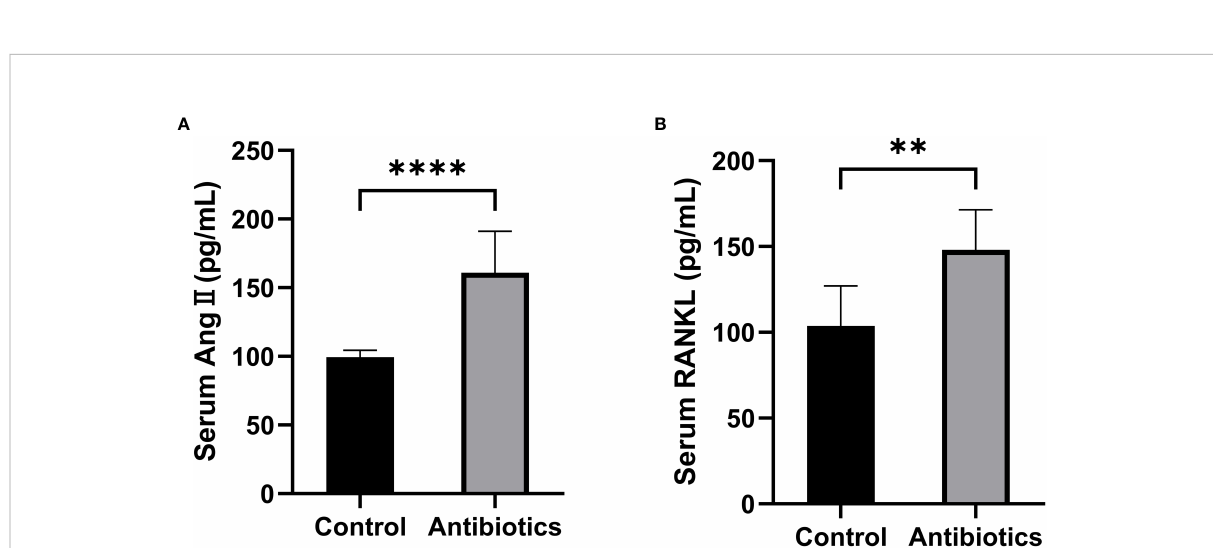
FIGURE 4 Comparison of serum Ang II and RANKL levels between the control group and the antibiotic group. (A) Serum angiotensin II (Ang II); (B) Receptor Activator for Nuclear Factor- k B Ligand (RANKL). **p<0.01,